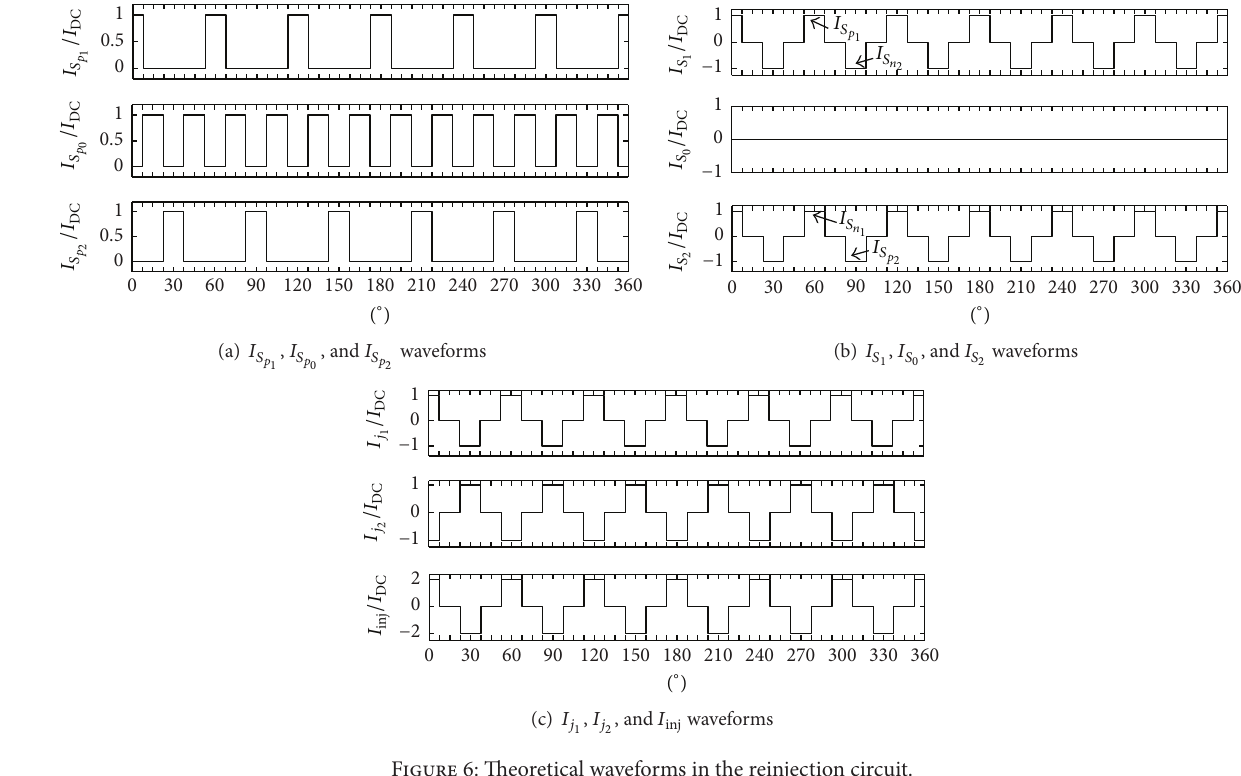
Figure 6: Theoretical waveforms in the reinjection circuit.